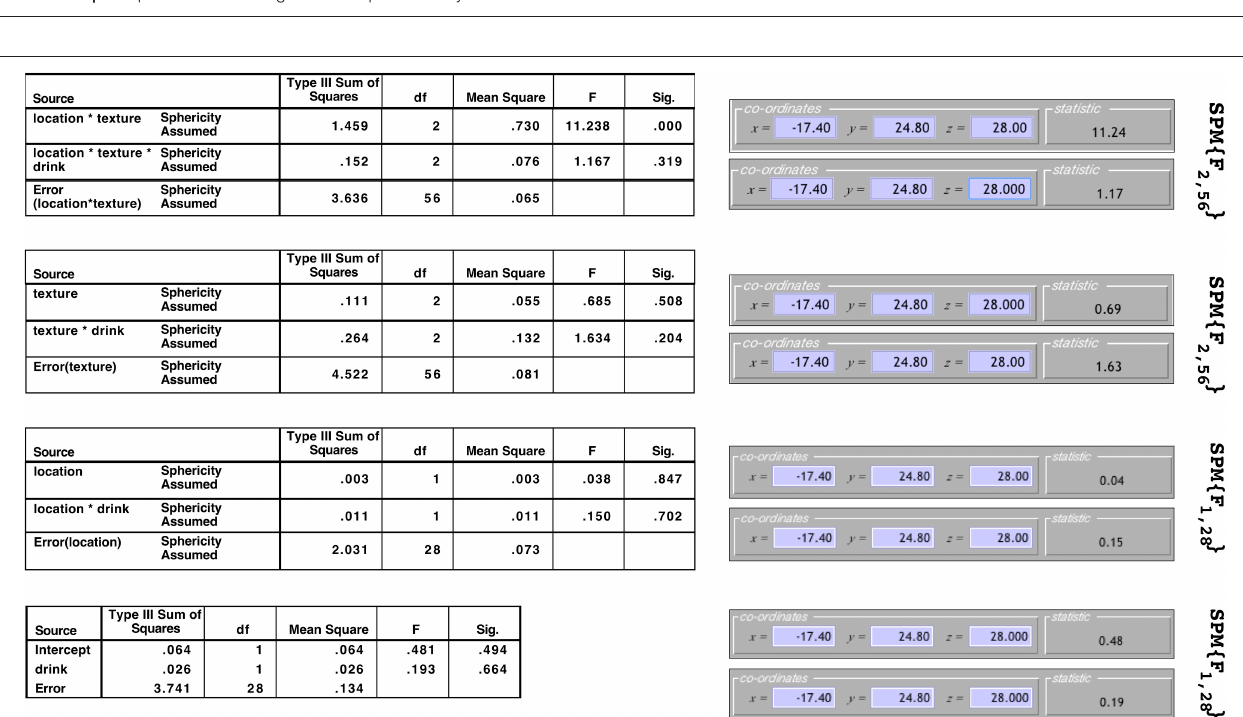
FIGURE 1 | Comparison of the design matrices produced by SPM12 for the different error terms.